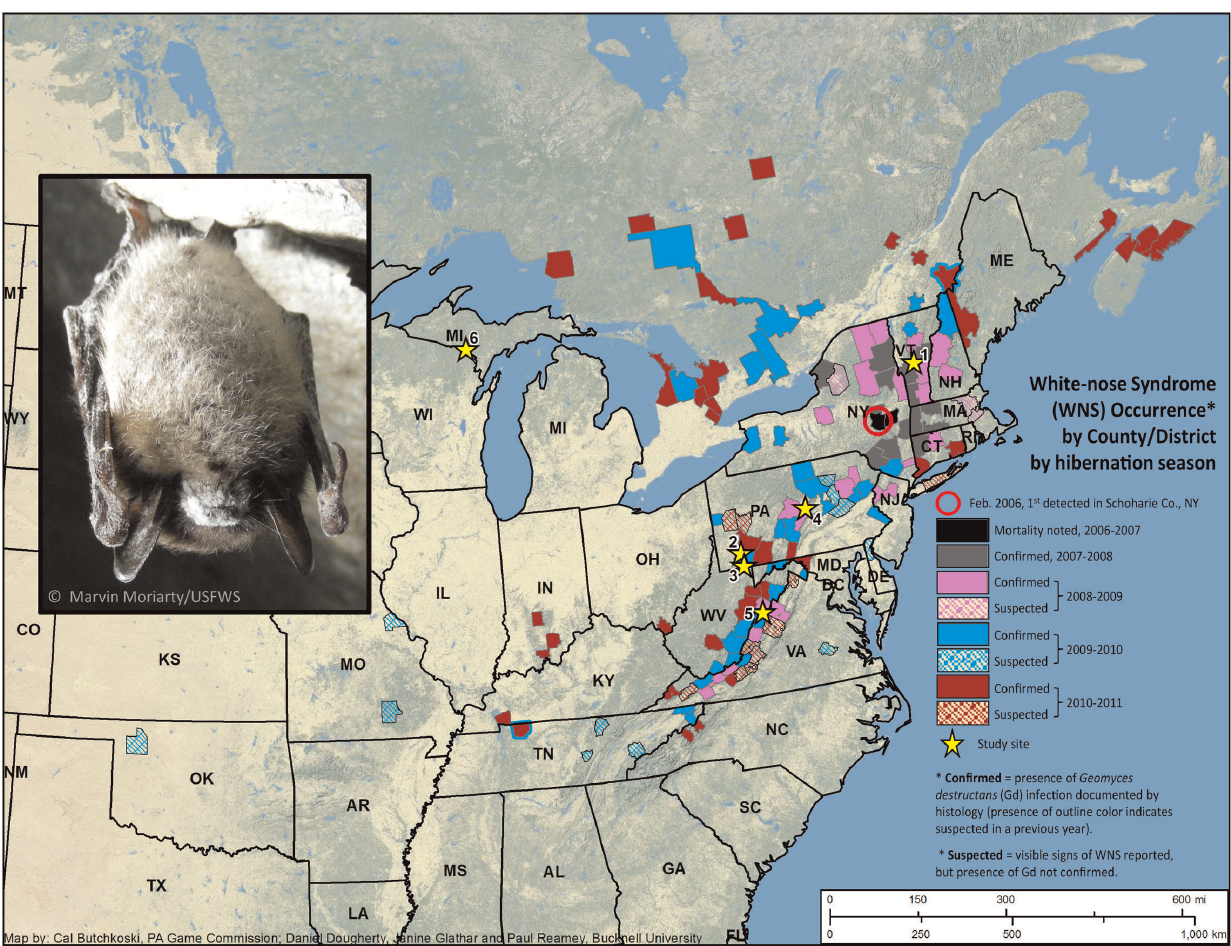
Figure 1. Distribution and spread of WNS throughout North America. Spread of WNS by hibernation season through the winter of 2010– 2011 is shown along with locations of study sites, indicated by stars (see also Table 1). Confirmed sites have been officially reported by each state or province based upon histological confirmation of infection with the fungal pathogen Geomyces destructans (Gd); bats from suspect sites have clinical signs of WNS but lack laboratory confirmation. The inset shows a little brown bat infected with Gd from site # 1 in Vermont. This site was WNS confirmed in 2008–2009, when bats were studied. Bats from site # 2 in Pennsylvania were studied in 2008–2009 (for 8 weeks only in the spring), when no signs of WNS were present, in 2009–2010, when a single bat from this site showed infection with Gd without mass mortality and in 2010– 2011, when bats in this site were heavily infected. Bats from site # 3 in Pennsylvania were studied in 2008–2009 (no WNS), 2009–2010 (when Gd was noted but without mass mortality) and in 2010–2011, when bats in this site were heavily infected. Bats from site # 4 in Pennsylvania were studied in 2009–2010 (for 8 weeks only in the spring), when bats were heavily infected. Bats from site # 5 in West Virginia were studied in 2008–2009, when there was no evidence of Gd presence – which was also the case for bats from site # 6 in Michigan, which were studied all three